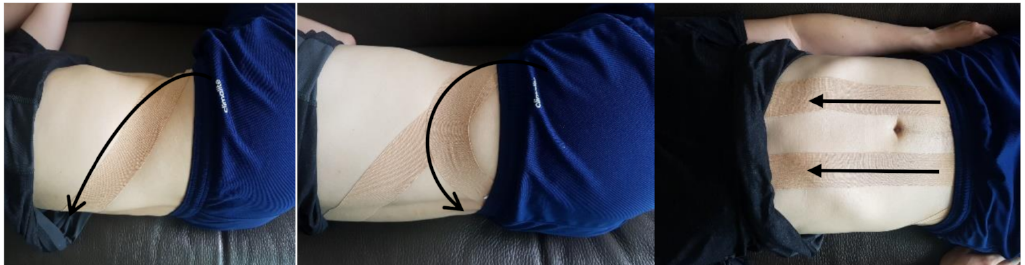
Figure 2. Application of the posterior pelvic tilt